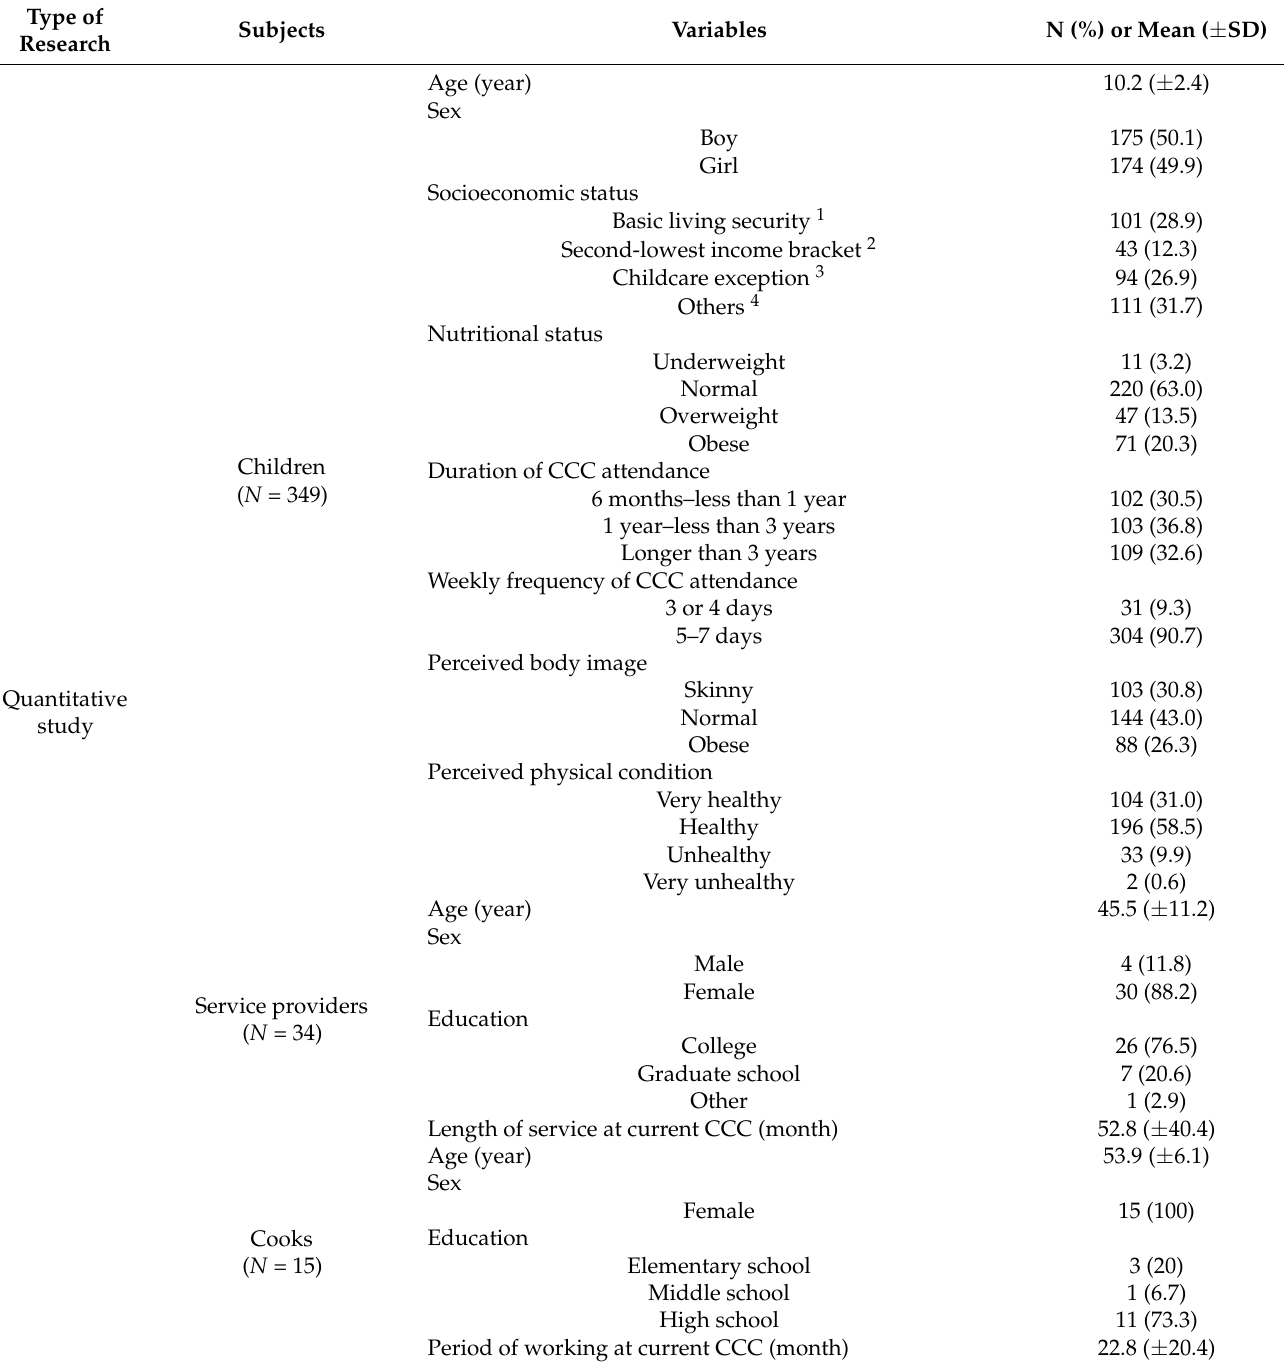
Table 1. General characteristics of the children and workers who enrolled in the mixed-method